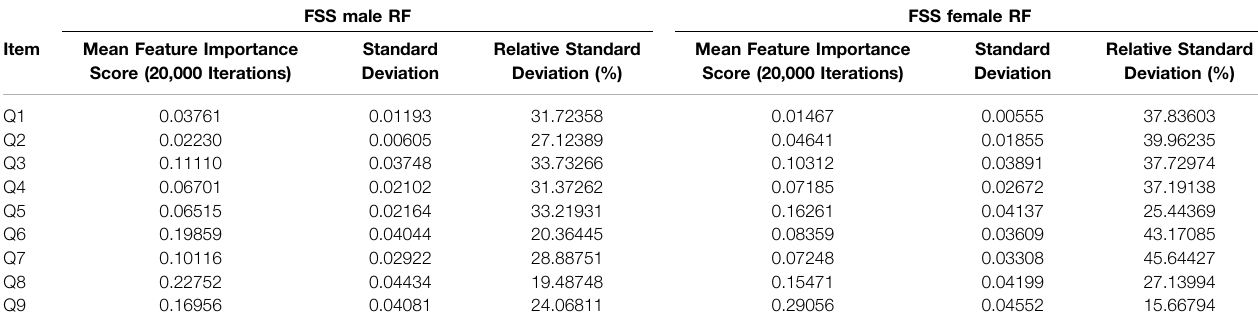
TABLE 2 | FSS male and female random forest mean feature importance scores for 20,000 iterations.